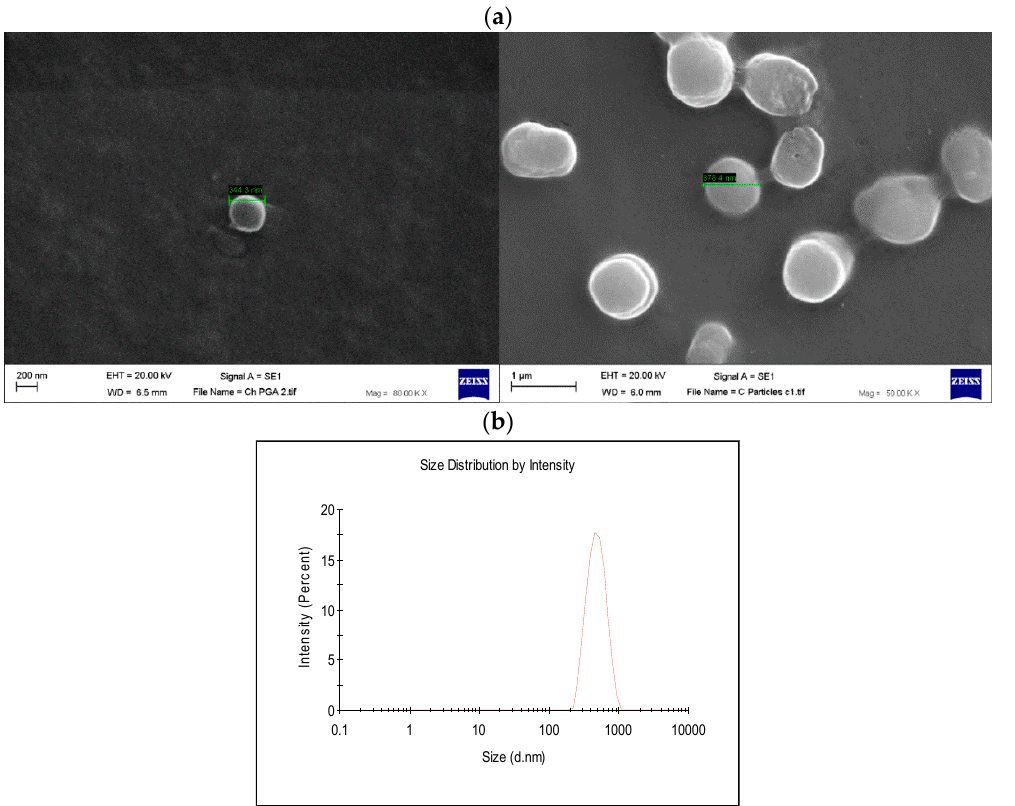
Figure 7. ( a ) Scanning electron microscopy (SEM) images of γ‐ PGA nanoparticles (NPs); ( b ) Dynamic light ‐ scattering (DLS) analysis of γ‐ PGA NP formed by ionic gelation method; γ‐ PGA NPs formed by the formulation of (0.05:0.15 CH: γ‐ PGA w / v ). Magnification power is 80,000× (left image) and 50,000× (right image).